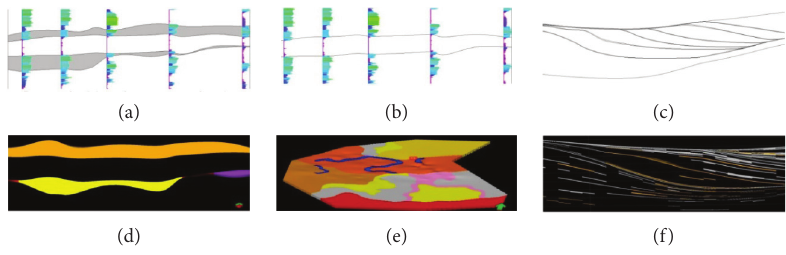
Figure 10: Water injection profiles in different periods under the control of intralayer barrier systems.